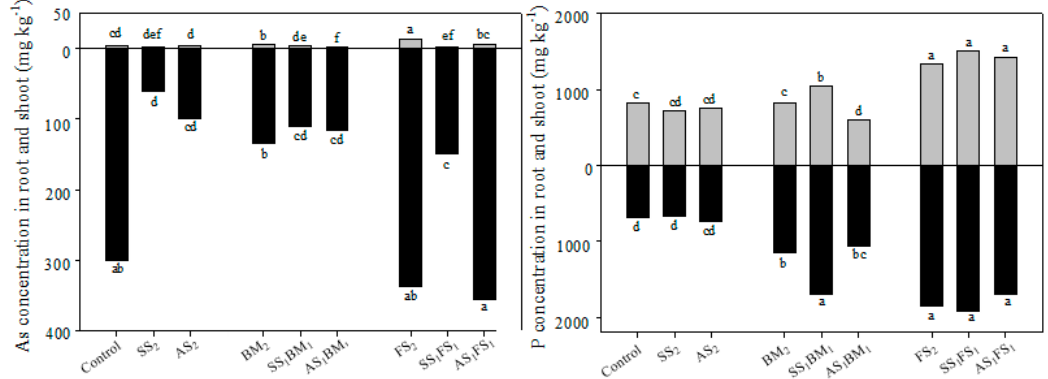
Figure 3. As and P concentrations in the roots and shoots of bok choy ( Brassica campestris L. ssp. chinensis Jusl.) cultivated for 3 weeks in soil treated with various combinations of amendments. Different letters indicate significant differences at the 5% level by Duncan’s test. The treatments indicated treatment combinations in Table 1; SS 2 , steel slag (SS) 2%; AS 2 , acid mine drainage sludge 2%; BM 2 , bone meal (BM) 2%, FS 2 , fused superphosphate (FS) 2%; SS 1 BM 1 , SS 1% + BM 1%; SS 1 FS 1 , SS 1% + FS 1%; AS 1 BM 1 , AMDS 1% + BM 1%; and AS 1 FS 1 , AMDS 1% + FS 1%.